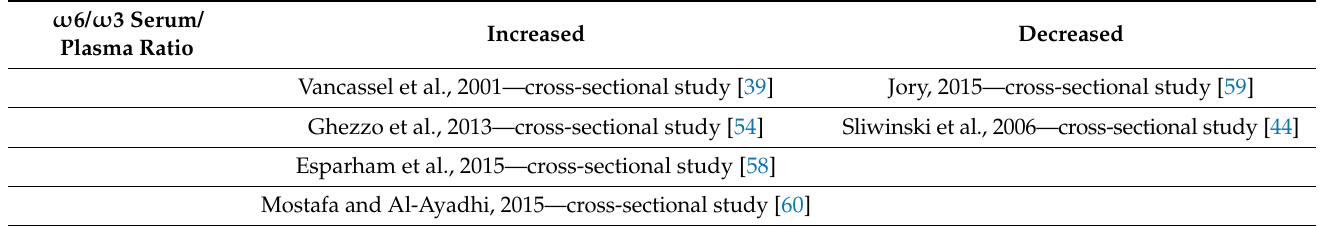
Table 3. Associations between serum/plasma ω 6/ ω 3 ratio and Autism spectrum disorders.